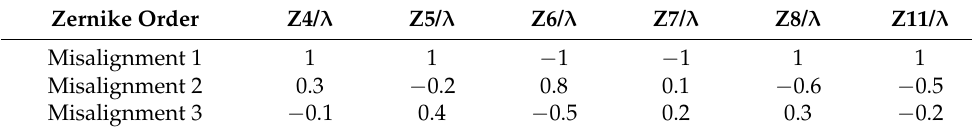
Table 2. Zernike coefficients corresponding to three misalignments.